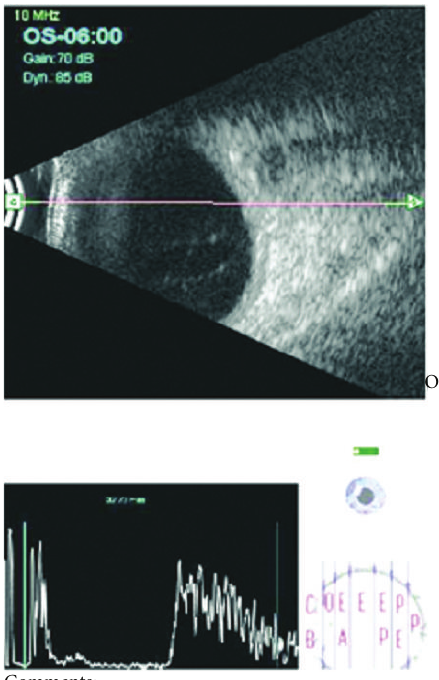
Comments: Figure 2: Ultrasound showing fine vitreous opacities with flat